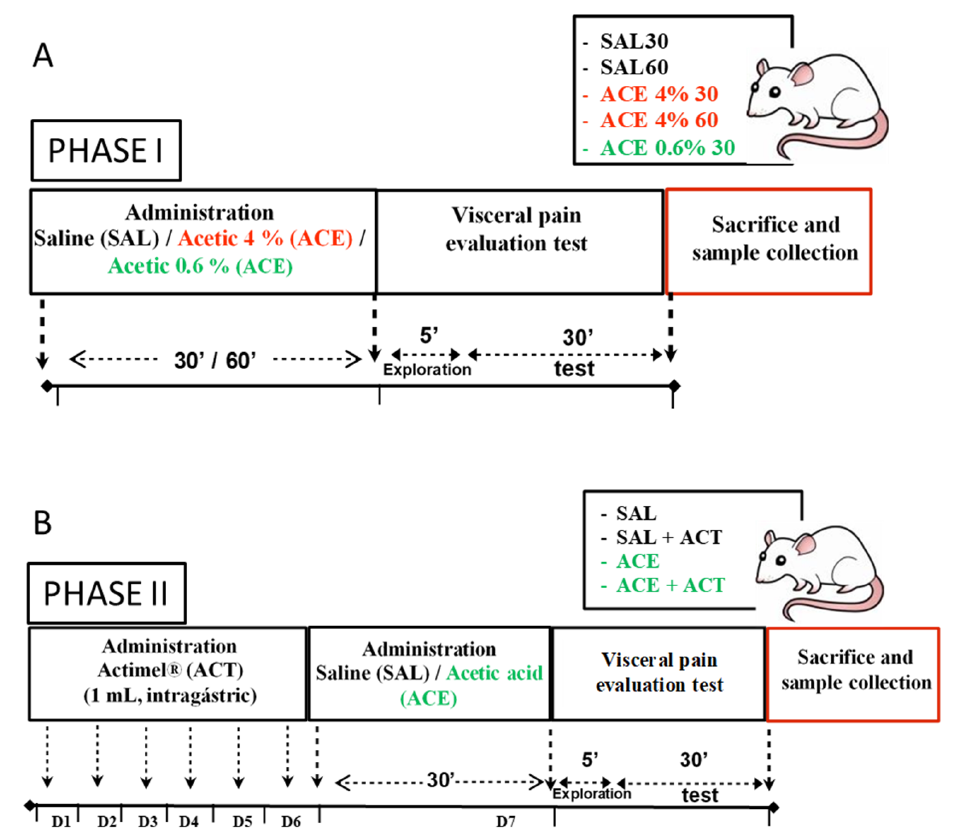
Figure 1. Experimental protocol. Young male Wistar rats were used. The study was divided into two phases. In both, functional (visceral sensitivity) and structural (colonic wall histology and immunohistochemistry) effects were evaluated. ( A ) Phase I, selection of the experimental model. For this, animals were administered intracolonic saline (control, SAL) or acetic acid (ACE) at two different concentrations: 0.6% (ACE 0.6%, IBS model, green); 4% (ACE 4%, IBD model, red). Visceral pain was evaluated 30 (SAL30/ACE30) or 60 (SAL60/ACE60) minutes after SAL/ACE administration (early stages of the models). ( B ) Phase II, evaluation of the effects of the prior administration of probiotics on the selected model (ACE 0.6% 30). For this, Actimel ® (ACT) was intragastrically administered at 1 mL/day for the 7 days prior to the performance of the visceral sensitivity test. Four experimental groups were evaluated in phase II, according to the substance intracolonically administered and whether they received ACT or not: SAL, SAL + ACT, ACE, and ACE + ACT.